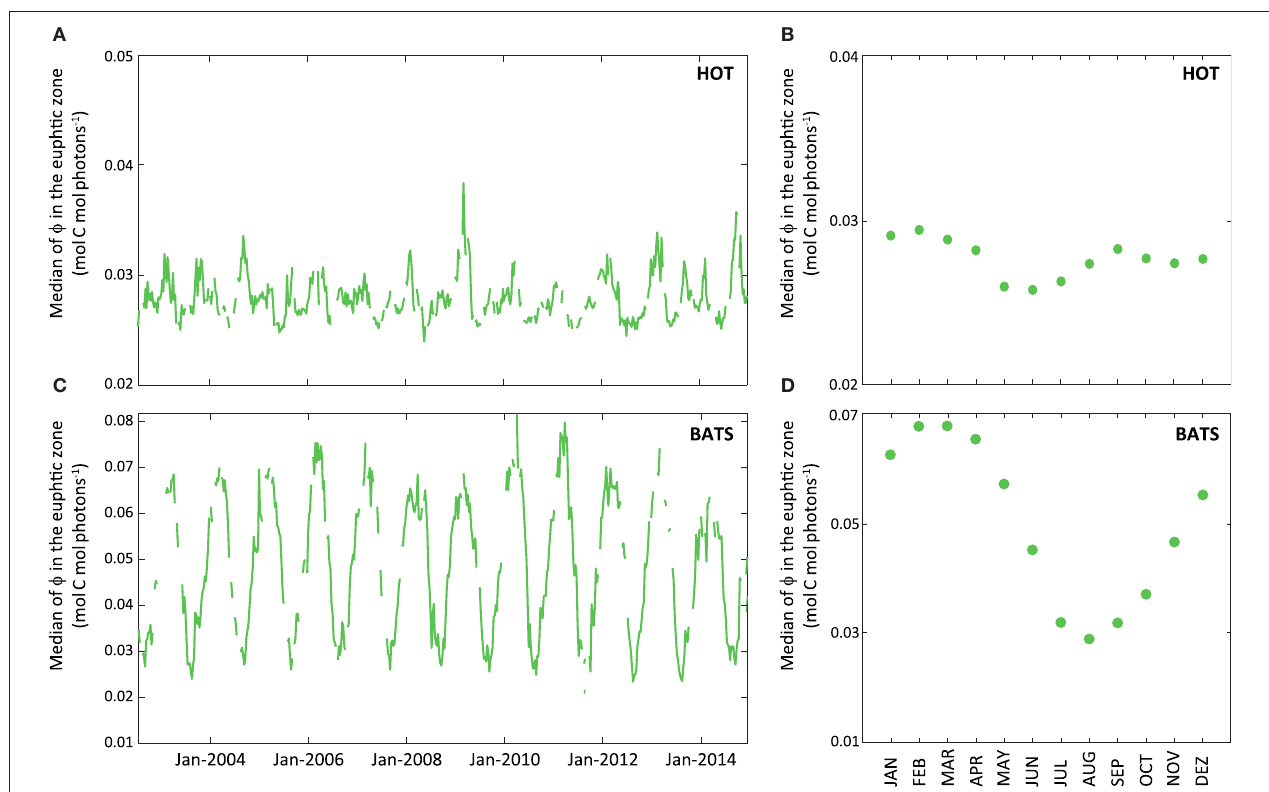
FIGURE 9 | Average of instantaneous φ (expressed in mol C mol photons − 1 ) within the euphotic zone obtained through MODIS-Aqua data for the whole data series (2002–2014). The green line represents the median of instantaneous φ for the euphotic zone (A) at HOT and (B) BATS. Aside, graphs (C) and (D) show the monthly median of φ for each of the stations obtained from satellite.